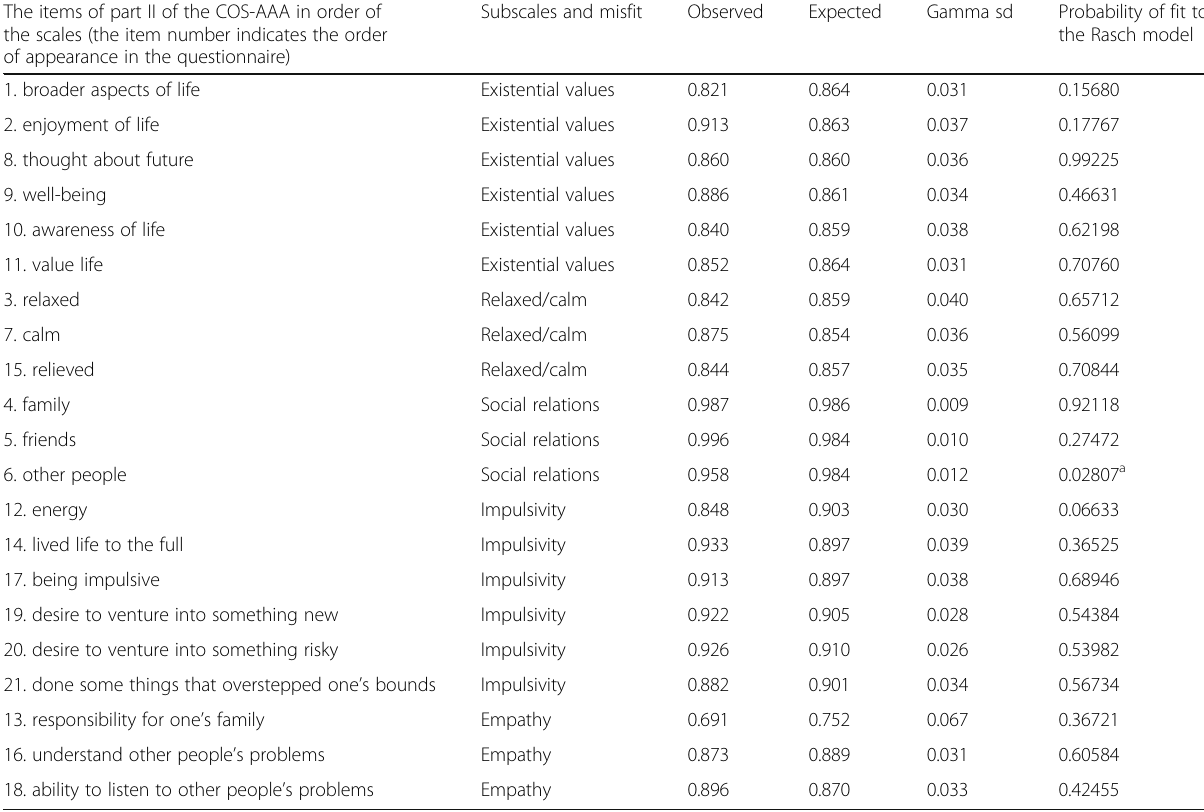
Table 5 Summary of result from the psychometric analyses of part 2 of the COS-AAA The items of part II of the COS-AAA in order of the scales (the item number indicates the order of appearance in the